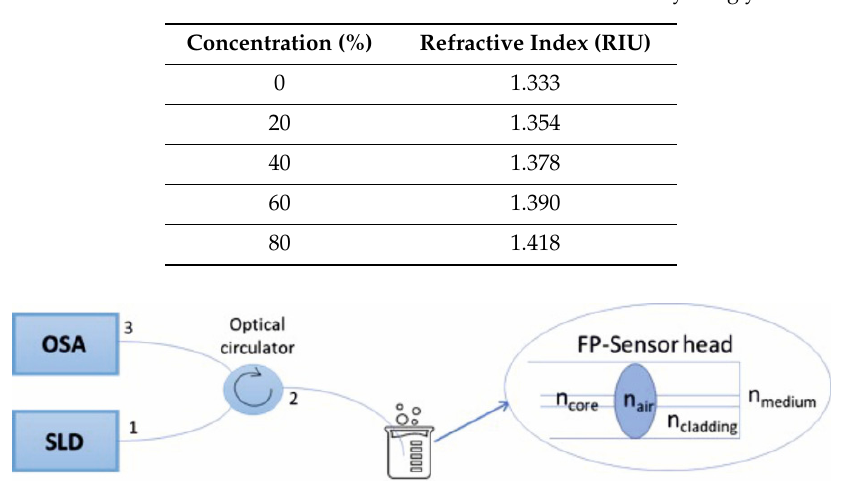
Figure 5. (a) Microphotograph of a microhole in the optical fiber’s tip, (b) splicer image of the air bubble, obtained just after electric arc discharge, and (c) microscope image of a cleaved FP fiber tip, with L 1 = 105 μ m and L 2 = 149 μ m.